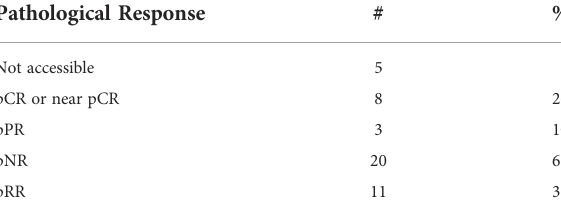
TABLE 5 Pathologic response rate (PRR) of patients with mucosal melanoma treated with neoadjuvant checkpoint inhibitors. Pathological Response